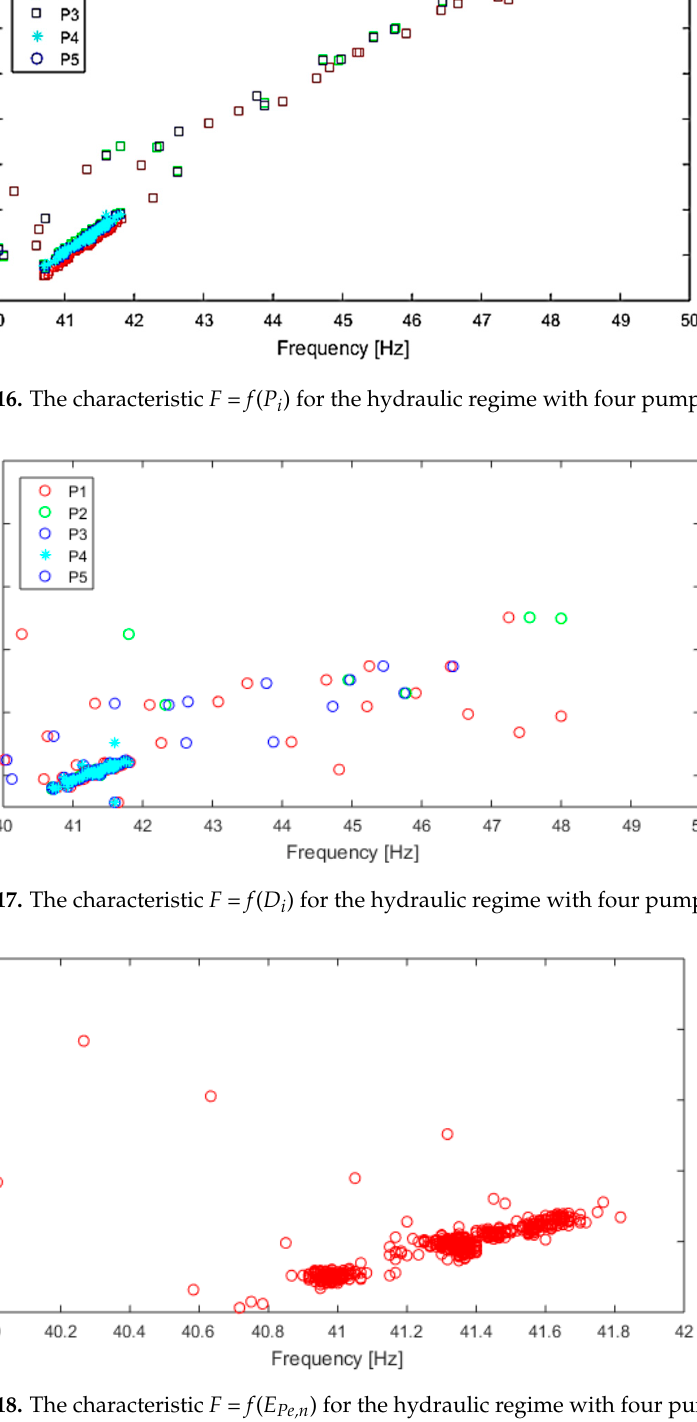
Figure 19. The characteristic F = f ( C_p i,n ) for the hydraulic regime with four pumps in operation. 3.4. The Maximum Efficiency Point Determination Using the Decision Matrix In the last step of the hybrid methodology proposed is to develop the decision matrix which takes into account the pumping cost, the pumping group efficiency and the total flow required at a constant pressure. This includes the optimal frequency band result from the graph analysis, when pumping cost is minimal. The maximum efficiency point is de- termined for each hydraulic operating regime. Thus, the decision matrix, where for the